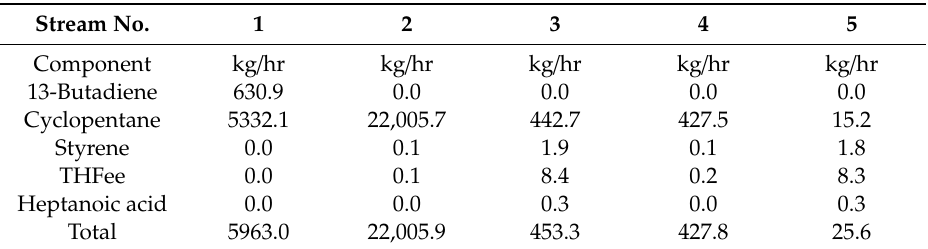
Table 14. SSBR plant HMB